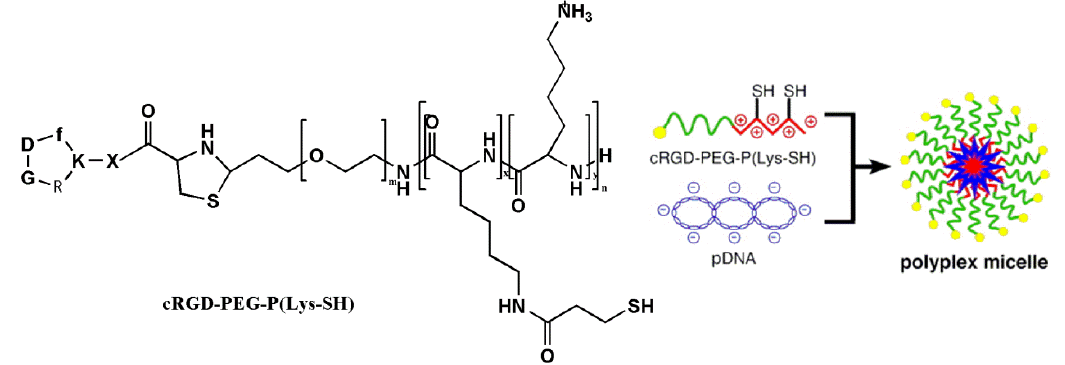
Figure 6. Structure of cRGD-PEG-P(Lys-SH) and its polyplex micelle. Reprinted with permission from [35].